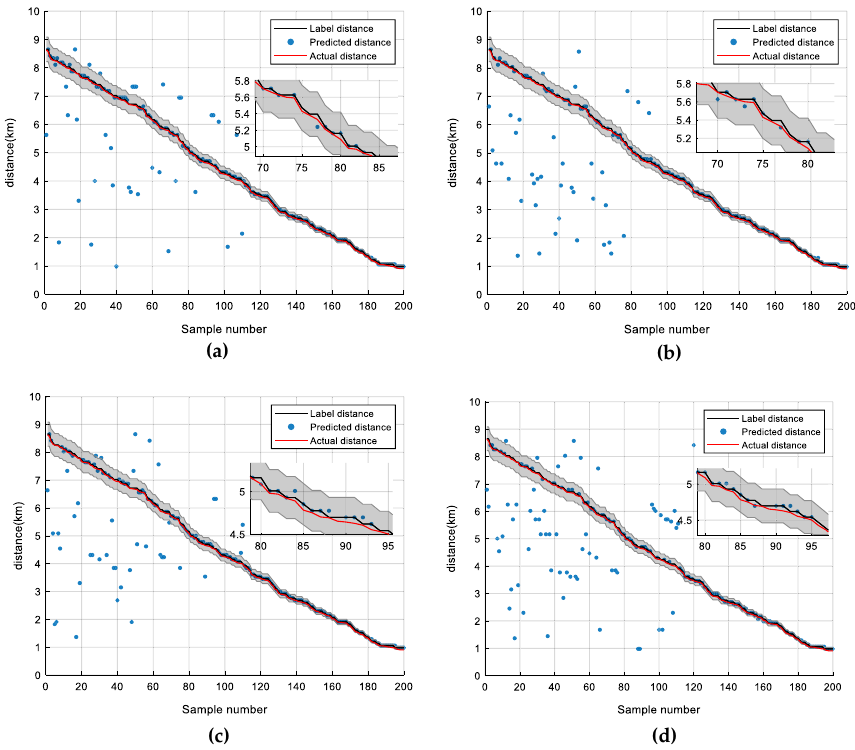
Fig. 9 Prediction plots for the narrowband dataset {163} Hz: a RA-CAE-SSL model; b CAE-SSL model; c RA- SL model; d CNN